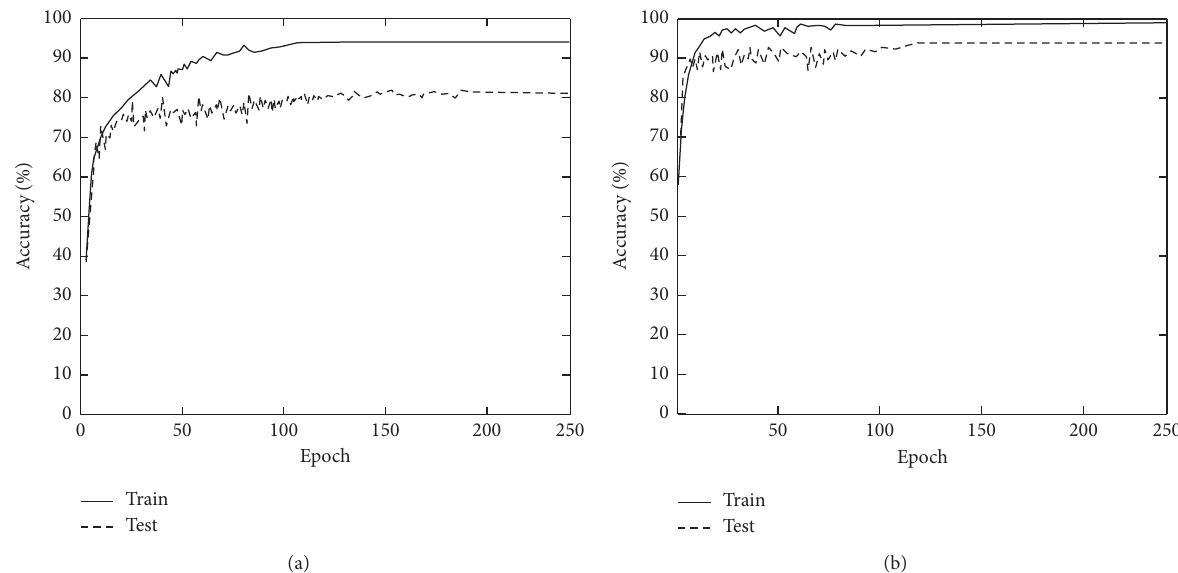
Figure 6: Expression recognition accuracy during training and testing. (a) VGG16 network training accuracy. (b) Improved VGG16 network training